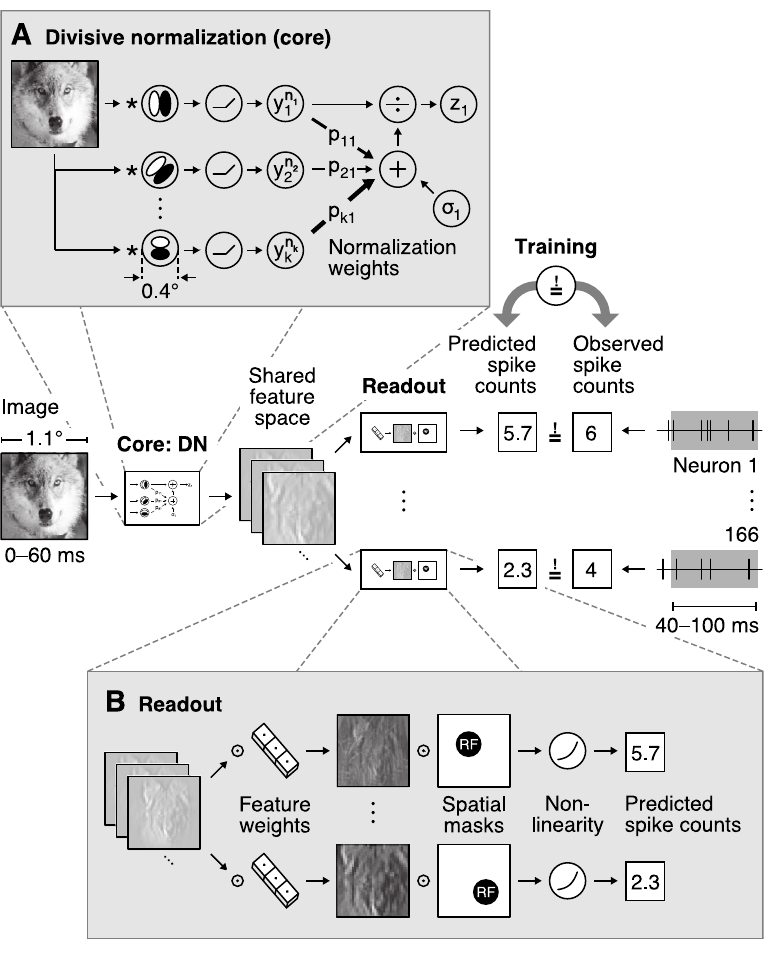
Fig 1. Overview of our divisive normalization (DN) model. The model takes as input an image covering 1.1˚ of visual field and predicts neurons’ spike counts in response to this image (details in Fig 2). The model is split into two parts: a core that computes a shared nonlinear feature space and a readout that maps the shared feature space individually to each neuron’s spike count. A . Divisive normalization mechanism (simplified). The visual input is convolved with 32 filters covering 0.4˚ of visual field and then rectified and exponentiated to produce an excitatory output. The output of each filter is then divided by a weighted sum of the excitatory outputs of all filters with normalization weights p kl and a semi-saturation constant σ l . In our general formulation, all weights and constants are learned from the data. B . Readout that maps the shared feature space to each neuron’s spike count through an individual weighted sum over the entire shared feature space and a pointwise output nonlinearity. The readout weights are factorized into a feature vector—capturing the nonlinear feature(s) that a neuron computes—and a spatial mask— localizing each neuron’s receptive field